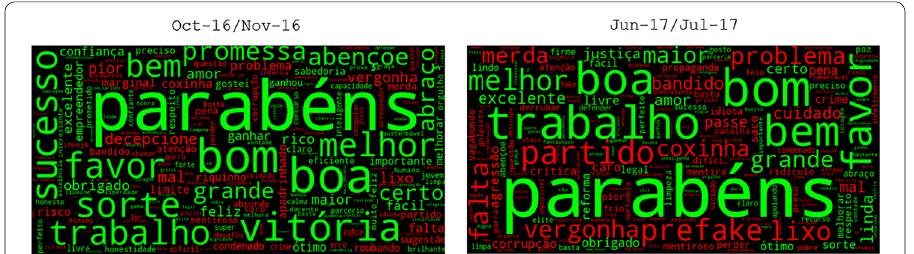
Fig. 5 Word clouds in the Oct-16/Nov-16 and Jun-17/Jul-17 bimesters (Source: prepared by the